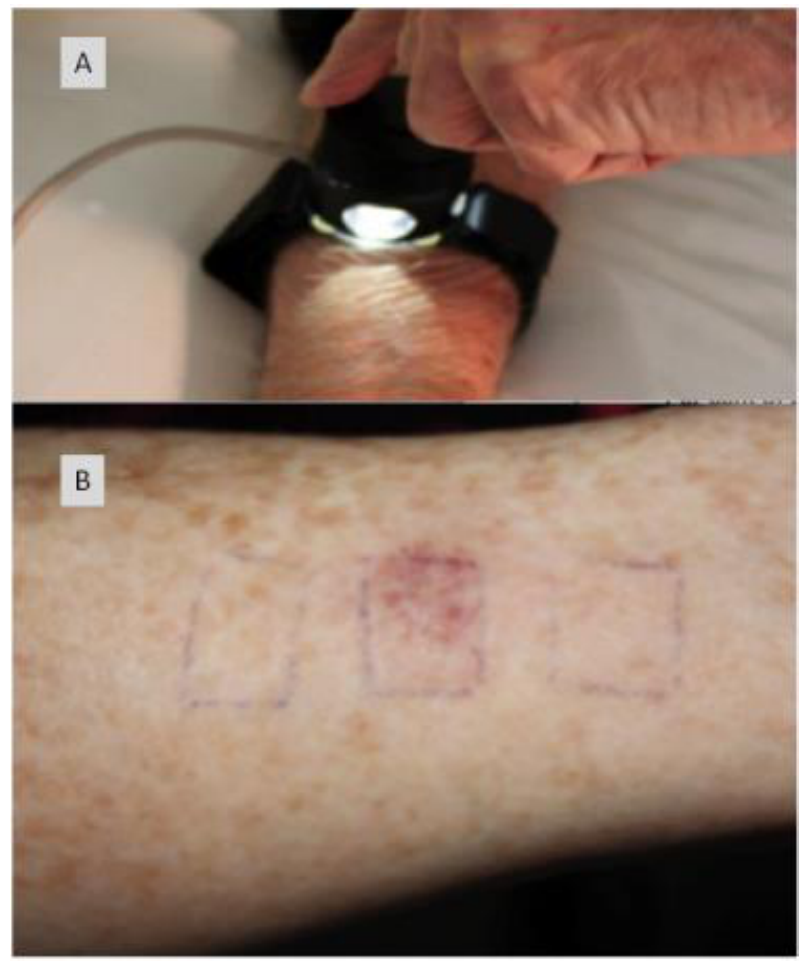
Figure 13. Skin photosensitivity testing in the phase I PCI trial. This was assessed and recorded at definite intervals (days 0, 1, 3, 6, 14, and 28, and at 3 months). Skin photosensitivity tests were undertaken with white light at two intensities: 500 lux and 100,000 lux for durations ranging from 30 s-5 min. Separate 0.8 cm spots on the inside of the arm were exposed to light and patients were assessed at two intervals (1 h and 24 h) after exposure. It was considered vital to report any local skin changes as these could indicate phototoxicity. The scoring of skin photosensitivity was descriptive. ( A ) shows the testing method, ( B ) shows mild skin reaction (erythema). A remarkable discovery from the phase I study was that TPCS 2a -mediated PCI (of bleomycin) induced convincing tumour responses, even in this heavily pretreated cohort with advanced and / or recurrent malignancies. Although the maximum tolerated dose of TPCS 2a was established to be 1.0 mg / kg, robust anti-tumour response was seen at all doses (including the started dose of 0.25 mg / kg). The outcomes suggest that photochemical internalisation had excellent potential for high tumour selectivity when treating cutaneous and subcutaneous malignancies, without causing severe damage to surrounding normal tissue. It was rather unanticipated that complete tumour responses were recorded in cases with malignancies depth of up to 38 mm, which were only treated with surface illumination only [106]. Figure 14 illustrates the PCI process in a sixty-one-year-old female with metastatic squamous cell carcinoma to the torso